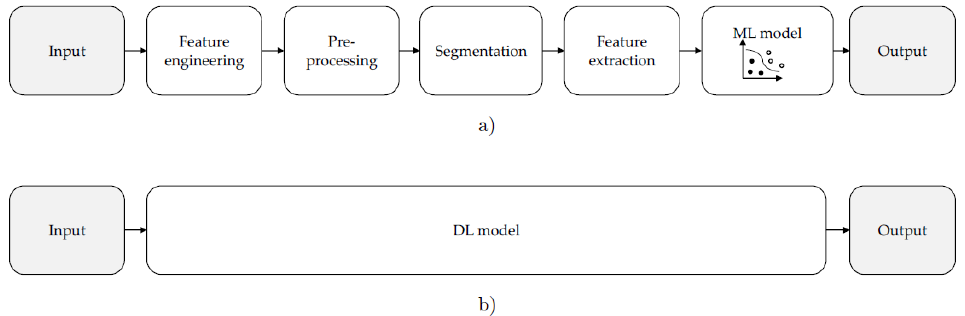
Figure 1. ( a ) Traditional computer vision methodology with ML. ( b ) Deep learning computer vision methodology.